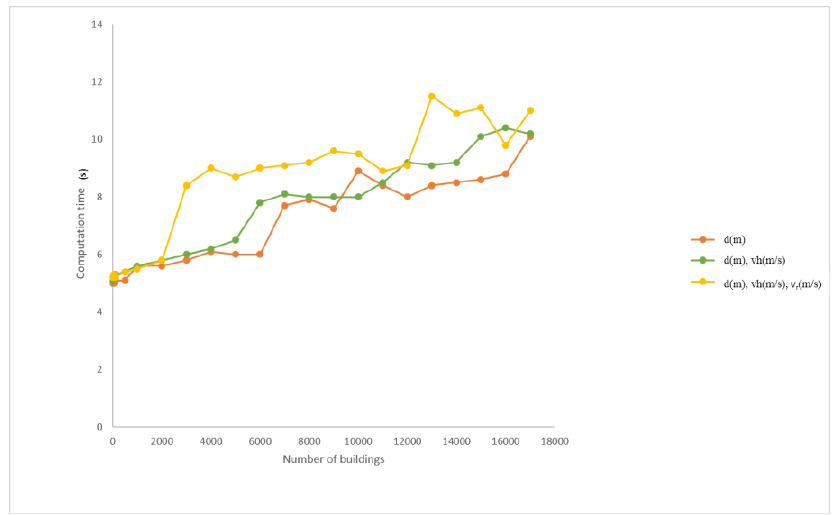
Figure 9. Time to run the query to detect the maximum water depth d and the maximum horizontal v h and vertical v r flood velocities for a number of buildings.